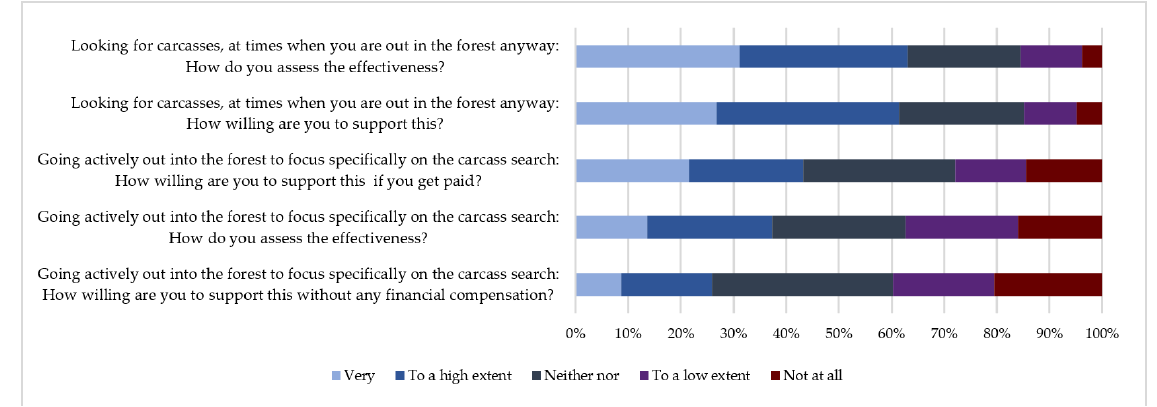
Figure 3. Evaluation of passive surveillance measures by Lithuanian hunters responding to the questionnaire survey.